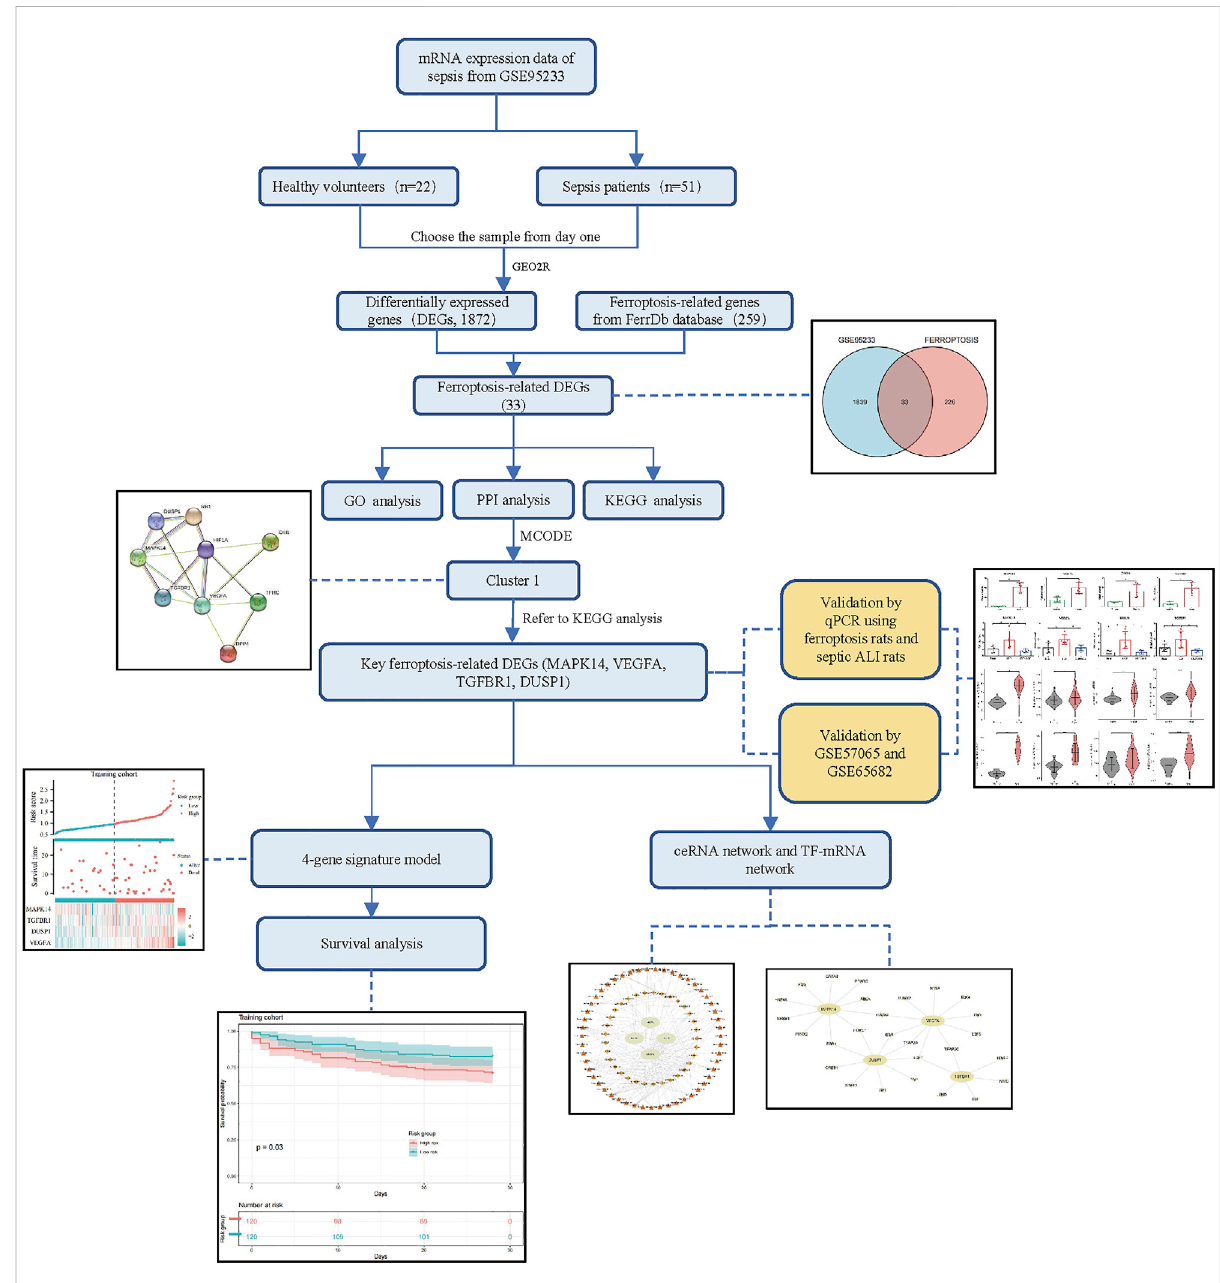
FIGURE 1 Flowchart of our